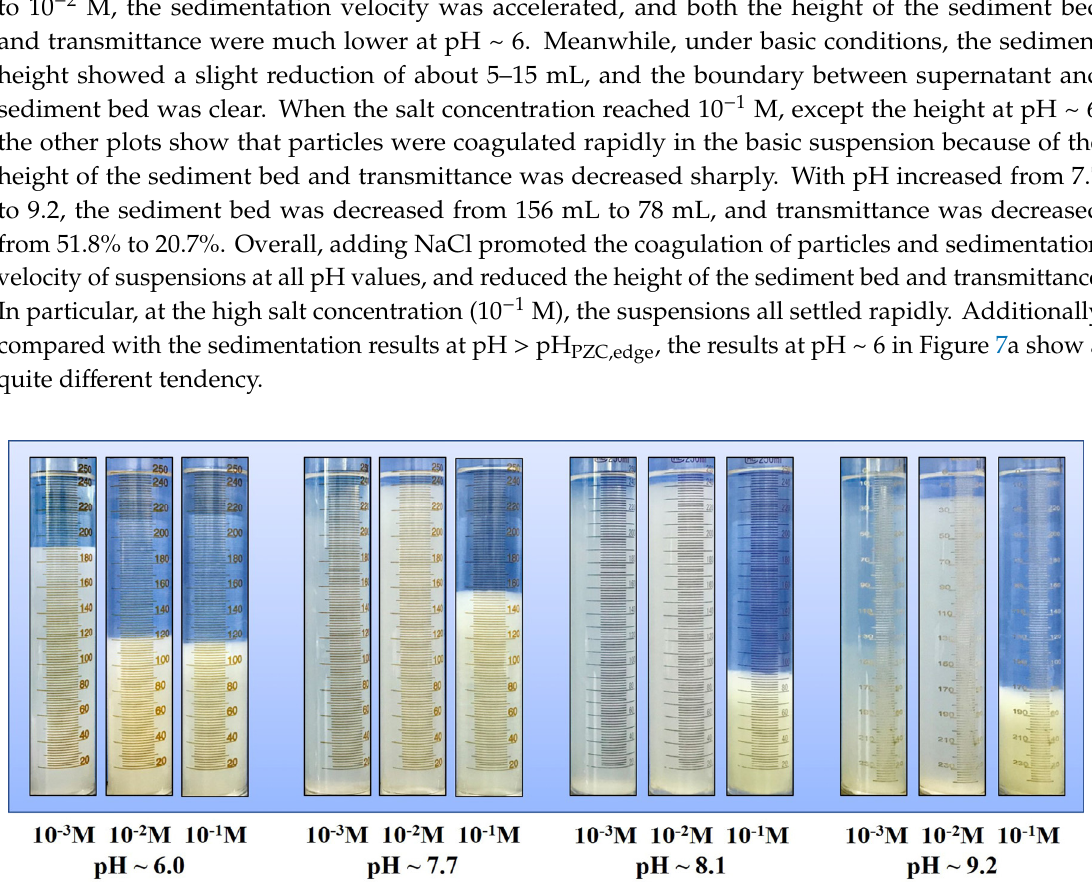
Figure 8. The changes in transmittance of Na-Mt suspensions through the sedimentation process with respect to increasing salt concentration as a function of pH. The test samples were taken from the 30 mL tick mark of the measuring cylinder.